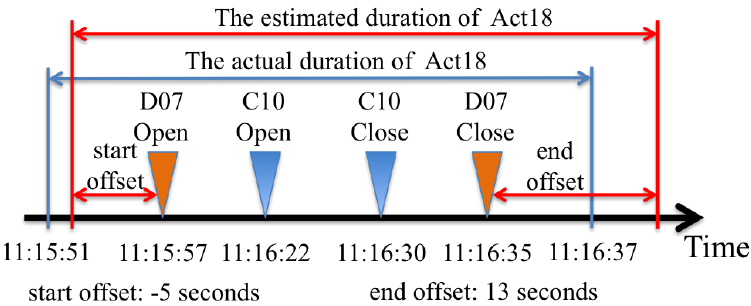
Figure 1. An example of estimating starting and ending times of Act18 in the morning segment of training day 1 in the training data. D07 and C10 are signature sensors for Act18. Note that the order of signature sensors in this case is not important, we only consider the first and the last signature events (orange).